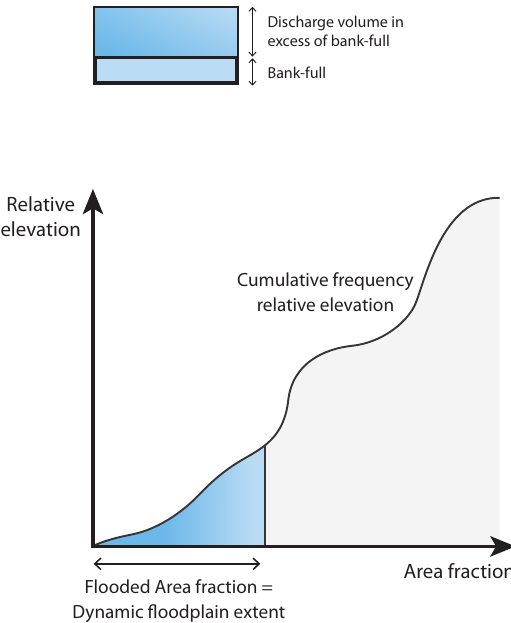
Fig. A1. Schematic of determining the static floodplain area and the dynamic floodplain extent (fraction flooded area) within a 0.5 × 0.5 ◦ cell based on bank-full discharge surface water level, ac- tual surface water level and a 1 × 1km digital elevation model. The discharge volume in excess of bank-full, as shown in the top figure, is mapped onto the cumulative distribution of floodplain elevation, as shown in the bottom